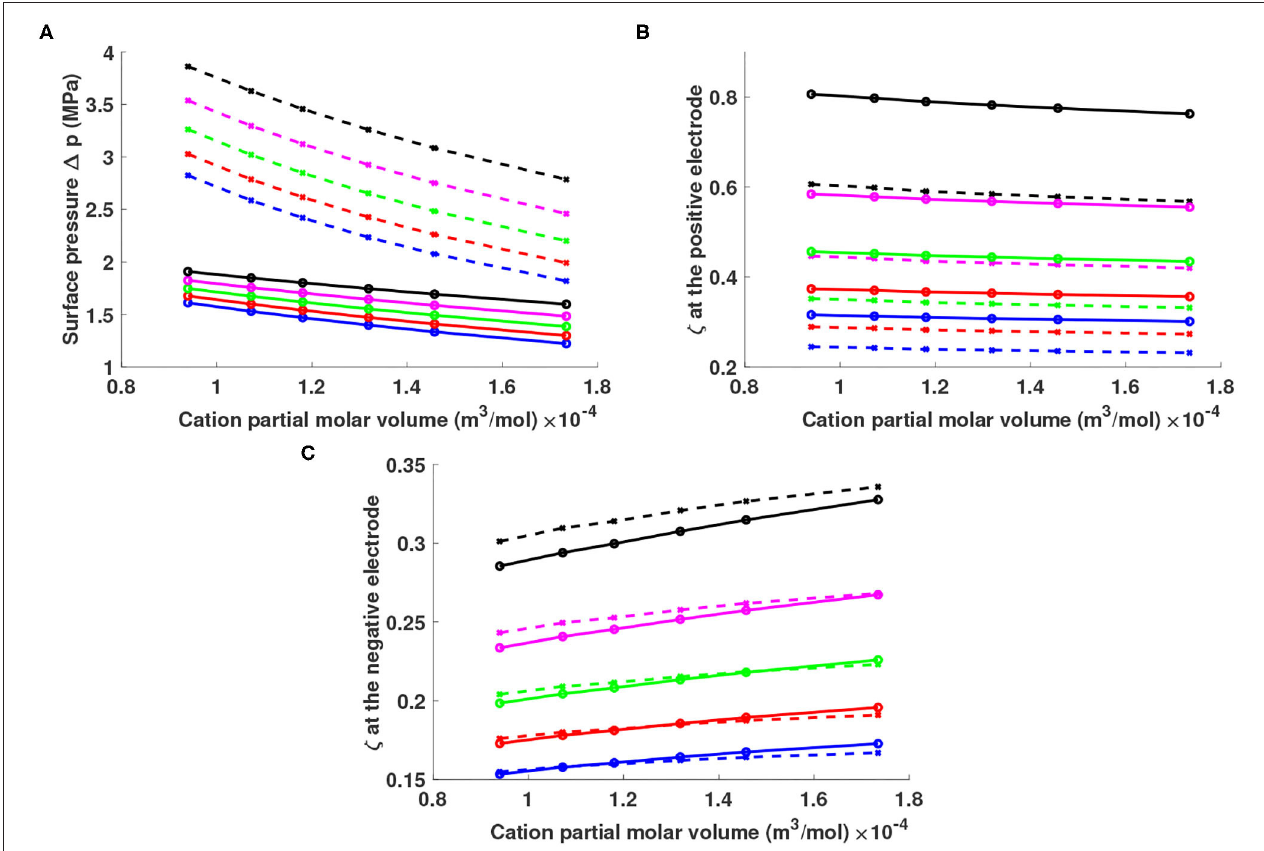
FIGURE 2 | (A) Surface pressure 1 p and lithium excess factor ζ at the (B) positive and (C) negative electrode for different mixtures of lithium salts Li + Y − in ionic liquids X + Y − . The horizontal axis shows the partial molar volume of cations X + , with points on the curves indicating the indicative values for C n mim + structures ( n = 2, 3, 4, 5, 6, and 8 as volume increases). Solutions were simulated with lithium particle fractions of 0.05 (blue), 0.1 (red), 0.15 (green), 0.2 (magenta), and 0.25 (black). Solid curves represent solutions containing Tf 2 N − anions; dashed curves represent solutions containing BF − 4 .